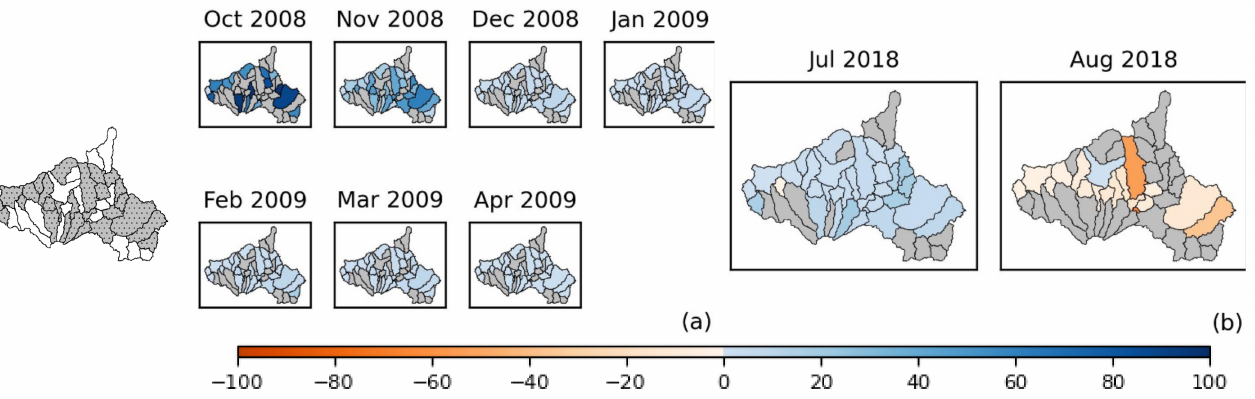
Figure 9. Drought severity change in percentage in the subbasins where the measure is applied, agricultural drought event II ( a ). Drought severity change in percentage in the subbasins where the measure is applied and in downstream subbasins, hydrological drought event V ( b ). The location of the measure is presented on the left side of the